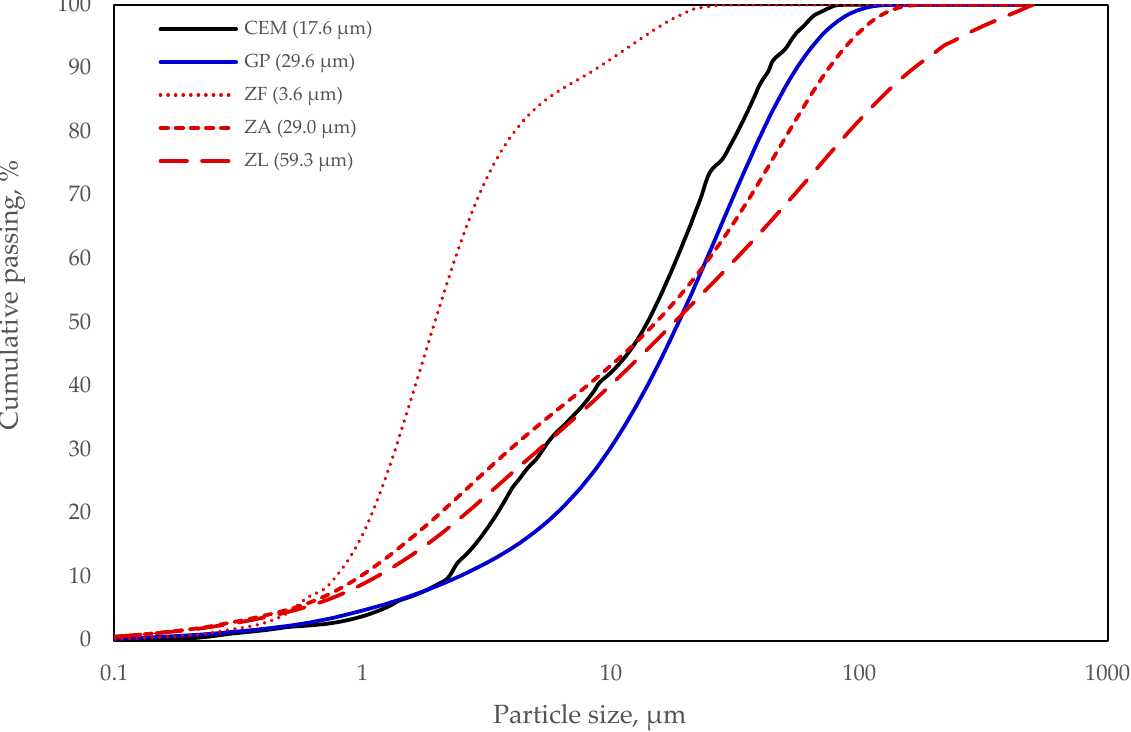
Figure 3. Cumulative passing chart of binder particle size.